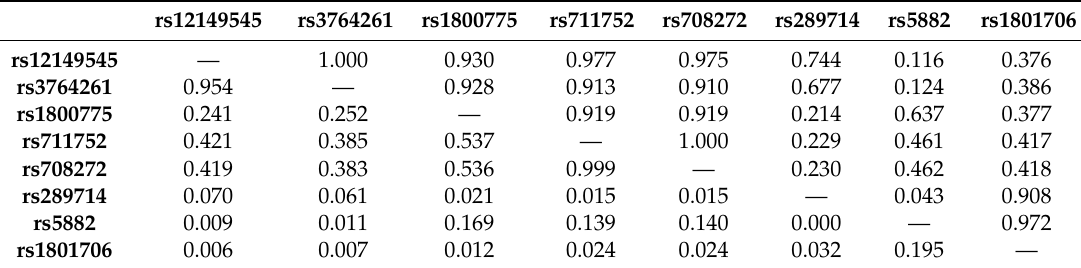
Table 4. Linkage disequilibrium test of CETP gene.